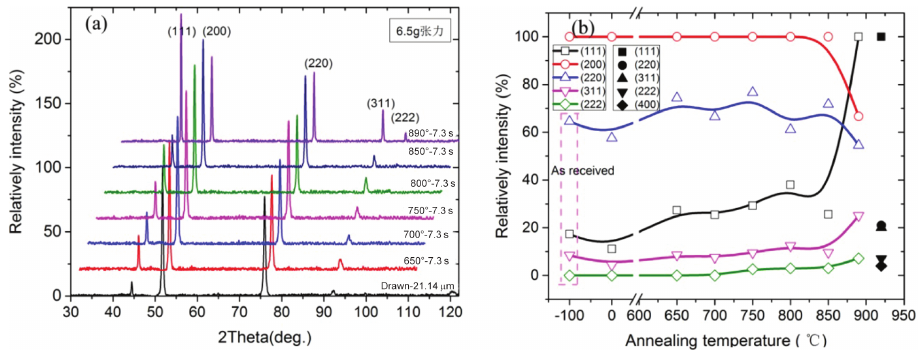
Figure 10: XRD patterns and diffracted intensity height of the deformed specimen with engineering strain of 46.6% as a function of annealing